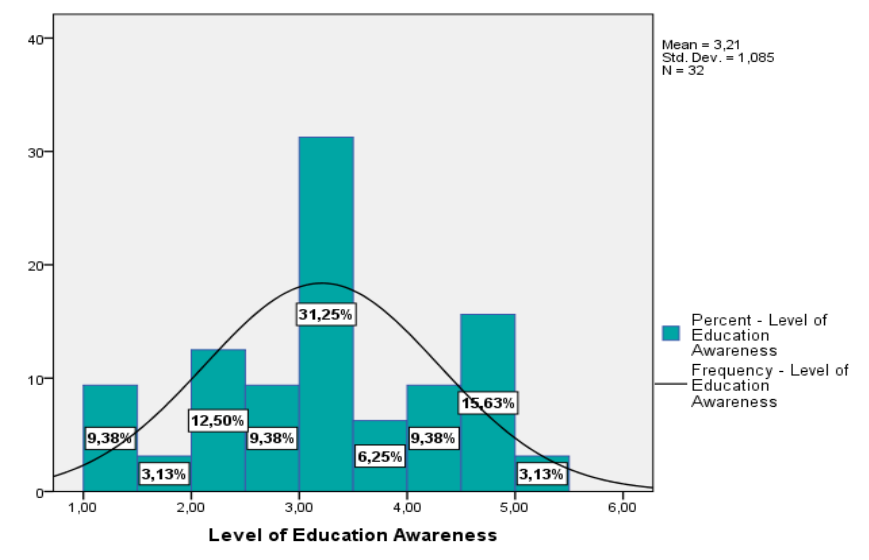
Fig. 6. Level of education awareness in Industry